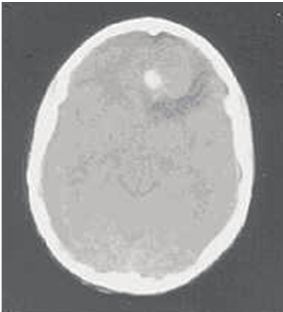
Figure 1: Unenhanced CT image of the index case (Case II: 2) showing a large lesion with a hyperattenuating centre surrounded by little spots of increased density (suggestive for calcifications and small areas of haemorrhage) in the left frontal lobe. Large edema coexists. Further histological examination proved this lesion to be a